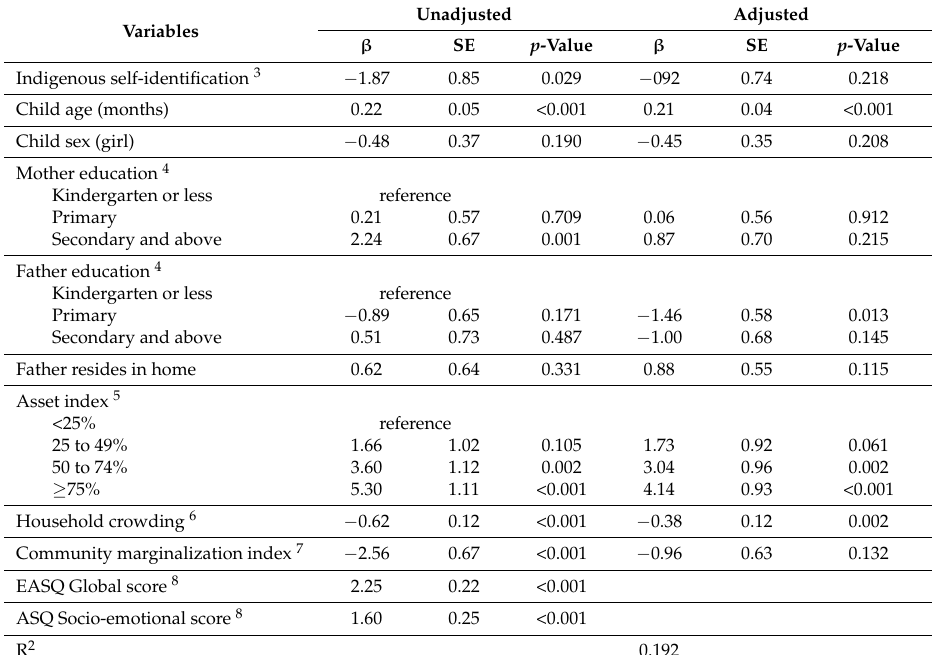
Table 5. Stratified OLS analysis of characteristics associated with variability in total HOME 1 Inventory score: Non-indigenous 2 communities ( n =